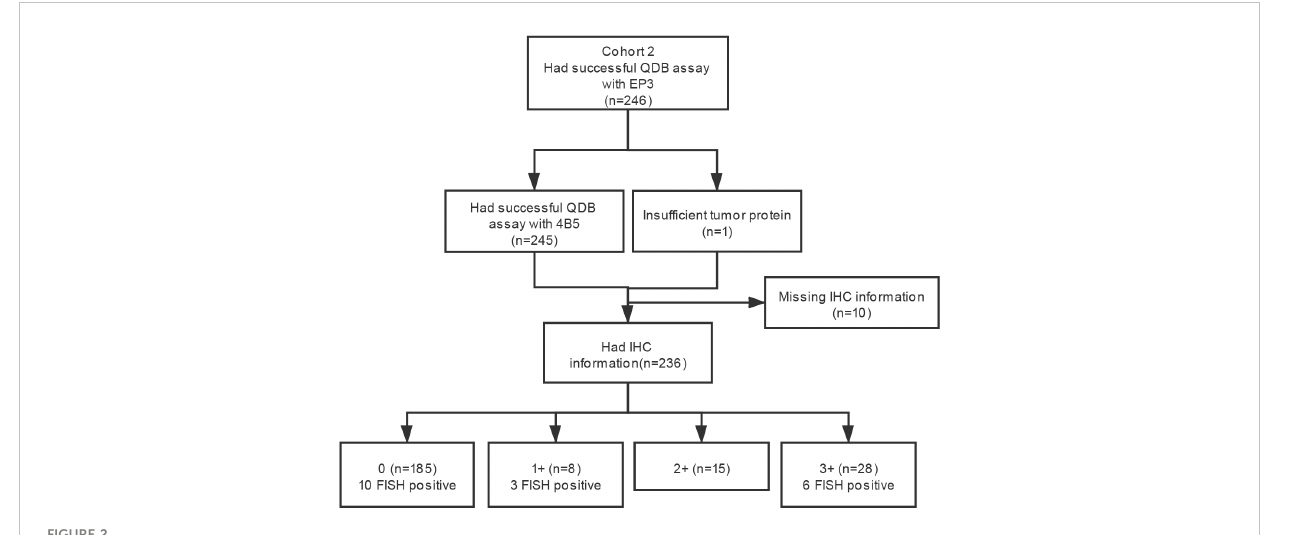
FIGURE 2 Flow diagram of patient selection for the study in cohort